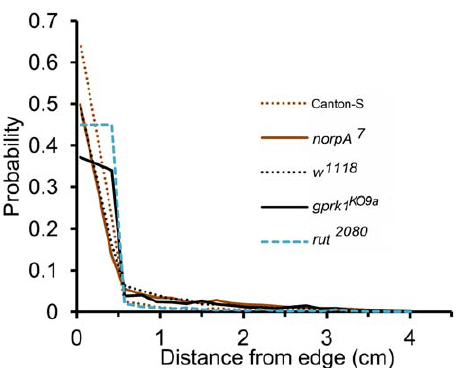
Figure 10. Radial distribution of four mutants and Canton-S flies in 4.2 cm circular arena. The mutants flies: w 1118 , (cid:2) n (cid:2) o (cid:2) r (cid:2) p (cid:2) A 7 , (cid:2) g (cid:2) p (cid:2) r (cid:2) k 1 KO 9 a and rut 2080 were found to spend 75%, 72%, 79% and 76% of their time within 0.6 cm of the arena boundary compared to 88% in Canton-S. There was a reduced wall preference in these mutants compared to Canton-S